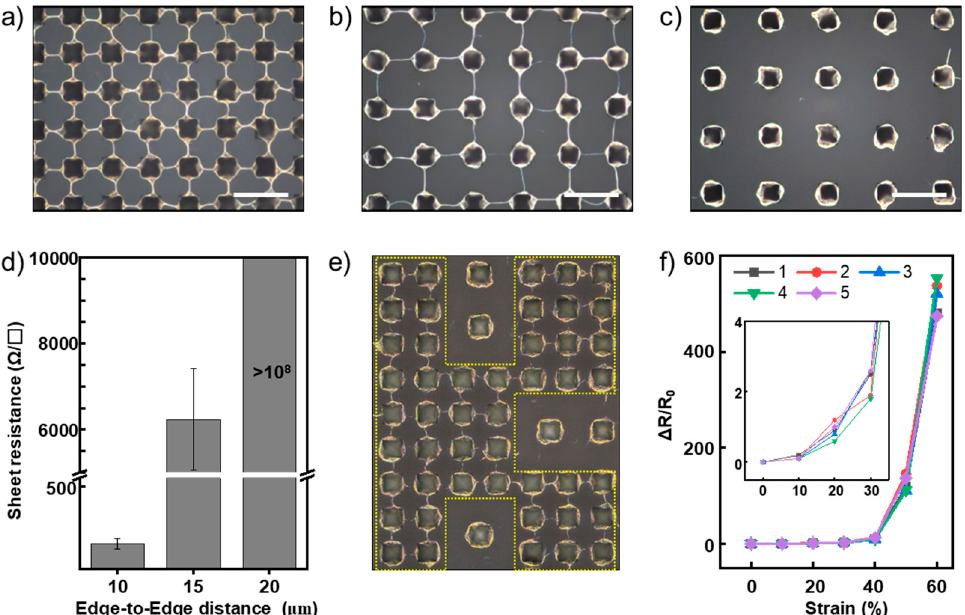
Figure 4. ( a – c ) Optical microscope images of AgNW deposited on microstructured substrates with various edge-to-edge distances between microstructures. Scale bar: 30 μ m; ( a ) 10 μ m; ( b ) 15 μ m; ( c ) 20 μ m. ( d ) Sheet resistances of the AgNW-deposited substrates shown in Figure 4a–c. In the case of the sample with an edge-to-edge distance of 20 μ m, the sheet resistance value exceeded 10 8 Ω / □ . The sheet resistance is the mean value of 5 samples, and the error bar indicates standard deviation. ( e ) Image of the letter “K” composed of the BSS bundle mesh developed by self-patterning characteristics. ( f ) Relative resistance change ( ∆ R/R 0 ) of 5 stretchable electrodes fabricated by repeatedly using the same microstructured PDMS